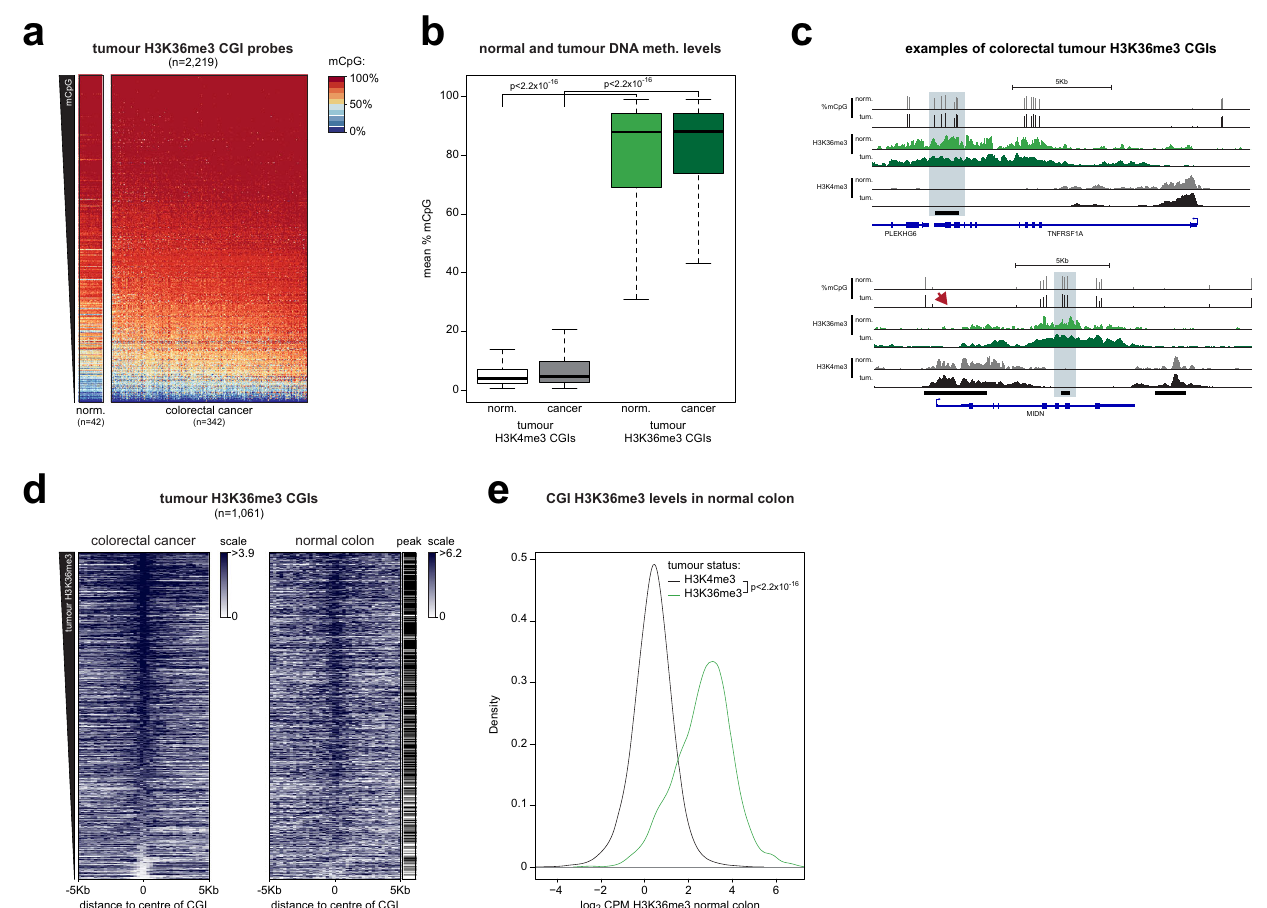
Fig. 5 H3K36me3 marked CGIs are methylated in colorectal tumours and the normal colon. a H3K36me3 marked CGIs are methylated in colorectal tumours. Heatmaps of methylation levels at probes located within H3K36me3 peaks and CGIs in colorectal tumours and adjacent normal colon samples. Both CpGs and samples are ordered by mean DNA methylation levels in colorectal tumours. norm. normal colon. b H3K36me3 marked CGIs are more highly methylated in colorectal tumours than H3K4me3 marked CGIs. Boxplot of the mean CpG methylation for probes located within CGIs and H3K36me3 or H3K4me3 peaks for 42 normal colon samples and 342 colorectal tumours. P -values are from two-sided Wilcoxon rank sum tests. Lines = median; box = 25th – 75th percentile; whiskers = 1.5 × interquartile range from box. c Examples of colorectal tumour H3K36me3 marked CGIs. Genome browser plots showing mean DNA methylation levels along with H3K36me3 and H3K4me3 signal for both the normal colon and colorectal tumours. CGIs and genes are shown below the plots. CGIs marked by H3K36me3 in the colorectal tumour are indicated in light blue. Arrow indicates lack of methylation at an H3K4me3 marked CGI. norm. normal colon, tum. colorectal tumour. Scale for methylation data is 0 to 100%. d Colorectal tumour H3K36me3 CGIs are marked by H3K36me3 in the normal colon. Heatmaps of H3K36me3 ChIP-seq at colorectal tumour H3K36me3 CGIs. The left panel shows colorectal tumour H3K36me3 levels and the right panel normal colon H3K36me3 levels at the same CGIs. CGIs are ordered by mean H3K36me3 enrichment in the colorectal tumour. Those overlapping ChIP-seq peaks in the normal colon are indicated next to the heatmap (black = peak). e Colorectal tumour H3K36me3 CGIs have high levels of H3K36me3 in the normal colon. Density histogram of normalised normal colon H3K36me3 counts at CGIs marked by H3K36me3 and H3K4me3 in the colorectal tumour. P -value from two-sided Wilcoxon rank sum test. Source data are provided as a Source Data fi